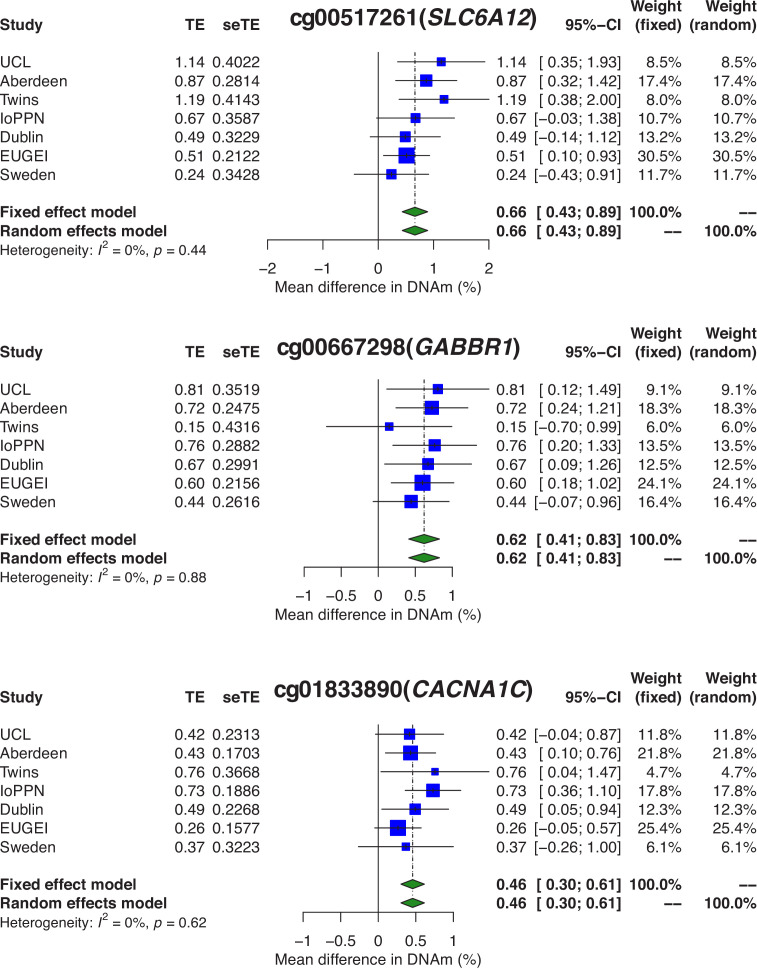
Psychosis-associated differential DNA methylation at sites annotated to genes previously implicated in disease etiology.Shown are forest plots for differentially methylated positions (DMPs) annotated to the GABA transporter SLC6A12 (cg00517261; p=1.53×10−8), the GABA receptor GABBR1 (cg00667298; p=5.07×10−9), and the calcium voltage-gated channel subunit gene CACNA1C (cg01833890; p=8.42×10−9). TE: treatment effect (i.e., the mean difference between cases and controls); seTE: standard error of the treatment effect.